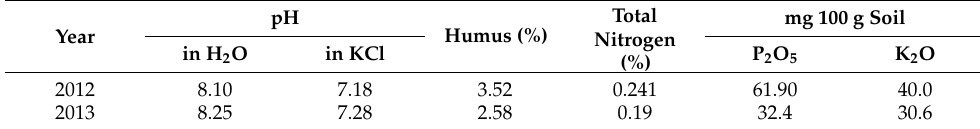
Table 1. Chemical properties of the soil.